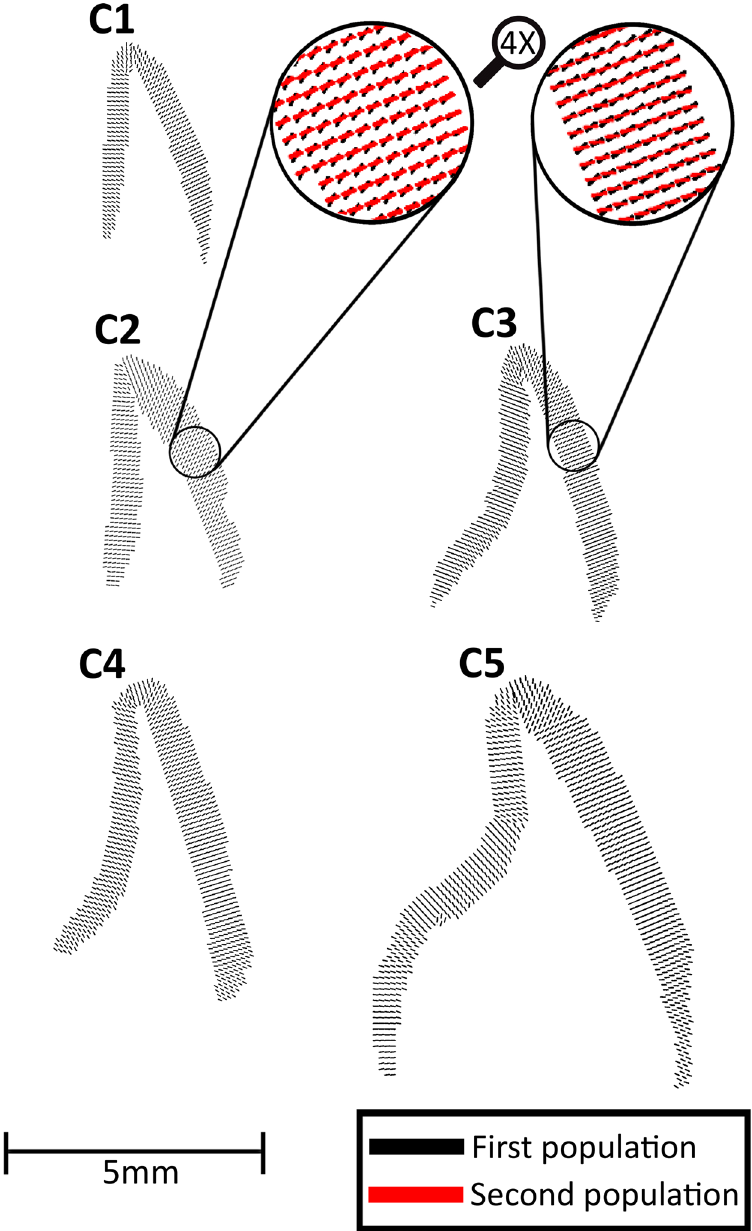
Figure 3. Texture direction maps of crystallites from the first orientation population in enamel at various developmental stages. Two regions were selected and magnified to show the texture directions of crystallites from both orientation populations. For each tooth section the labial surface is on the right hand